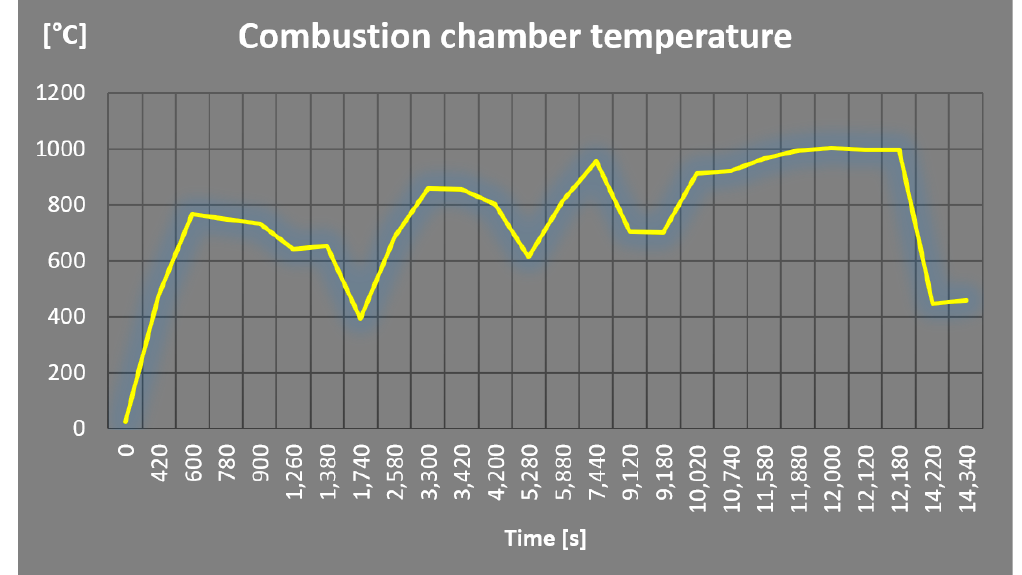
Figure 6. Combustion temperature. Energies 2019 , 12 , x FOR PEER REVIEW